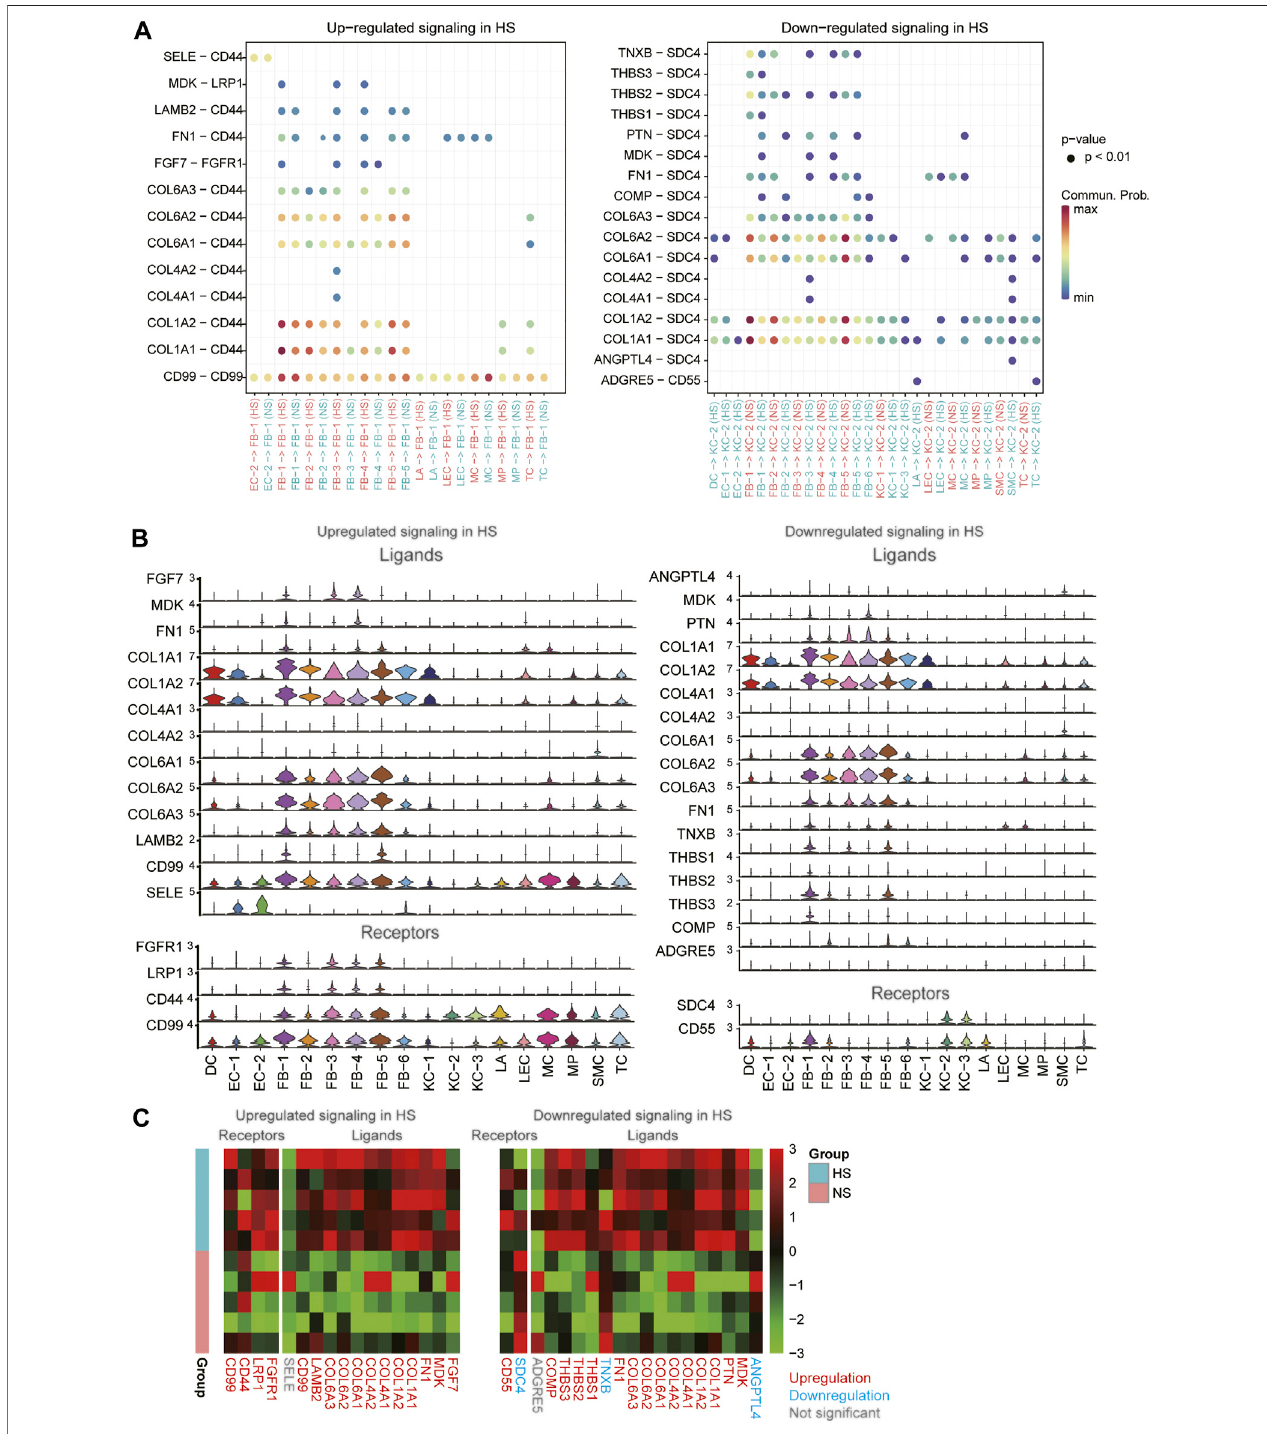
FIGURE6| Thedifferentialcell-cellcommunicationsbetweenHSandNS. (A) TheupregulatedanddownregulatedsignalinginHS.Thex-and y -axisrepresent the cell-cell communications and ligand-receptor pairs, respectively. (B) The expression levels of the ligands and receptors involved in the upregulated or downregulated signaling across the cell types. (C) The differential expression levels of the ligands and receptors between the HS and NS bulk RNA-seq samples.